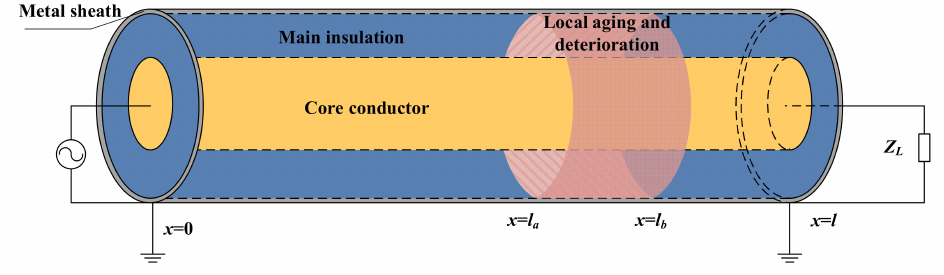
Figure 3. The schematic diagram of local aging and deterioration of single-core cable and its